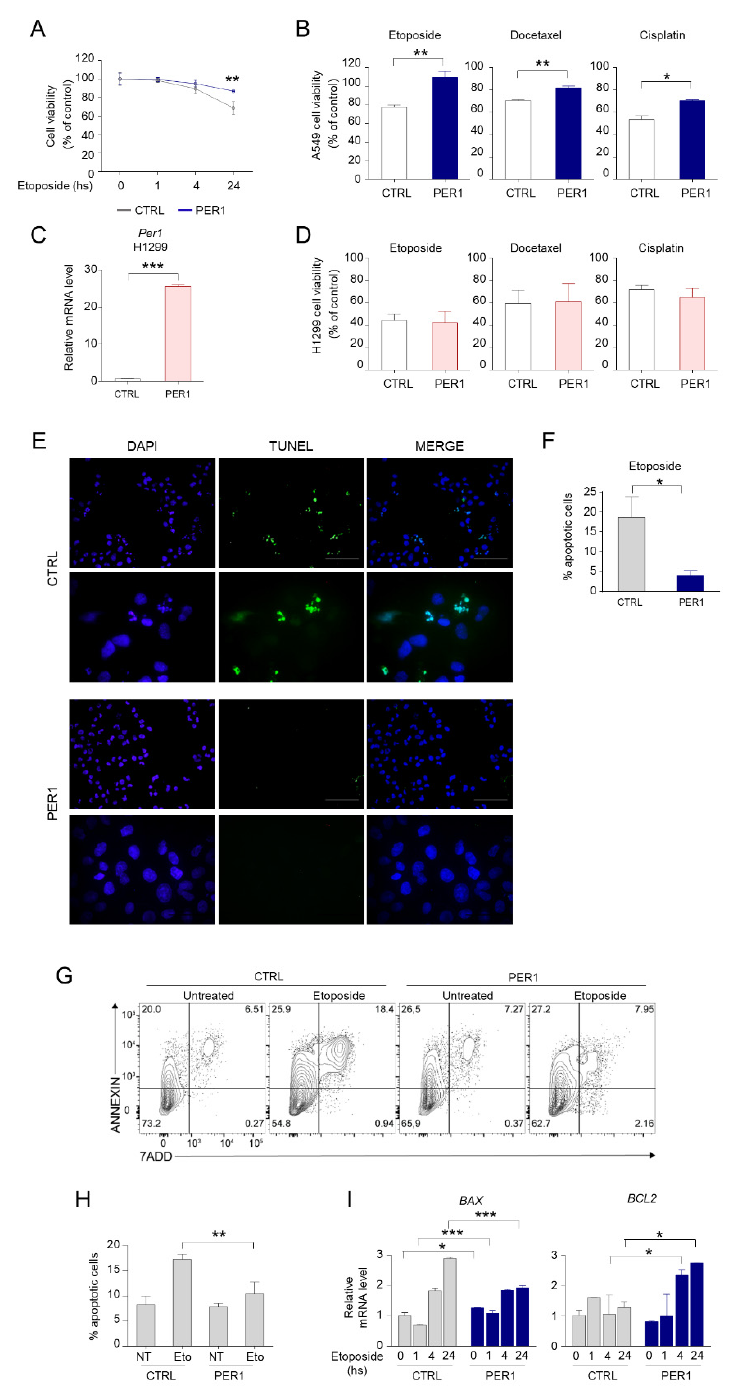
Figure 2. PER1 downregulation of apoptosis. ( A ) Cell viability following treatment with etoposide for the indicated time in A549 cells overexpressing PER1 or CTRL vector, measured by MTT assay and expressed as % of control untreated cells. Bars represent average ± SD (n = 3). (**) p < 0.01. ( B ) Cell viability following treatment with etoposide, docetaxel or cisplatin for 24 h in A549 cells overexpressing PER1 or CTRL vector, expressed as % of control untreated cells. Bars represent average ± SD (n = 3). (*) p < 0.05, (**) p < 0.01. ( C ) Control of PER1-overexpressing clones in H1299 cells, evaluated by qPCR. H1299 cells were transfected with PER1 or a control plasmid (CTRL, pEGFP N1) and positive clones were selected with G418 treatment. Bars represent average ± SD (n = 2). (***) p < 0.001. ( D ) Cell viability following treatment with etoposide, docetaxel or cisplatin for 24 h in H1299 cells overexpressing PER1 or CTRL vector, expressed as % of control untreated cells. Bars